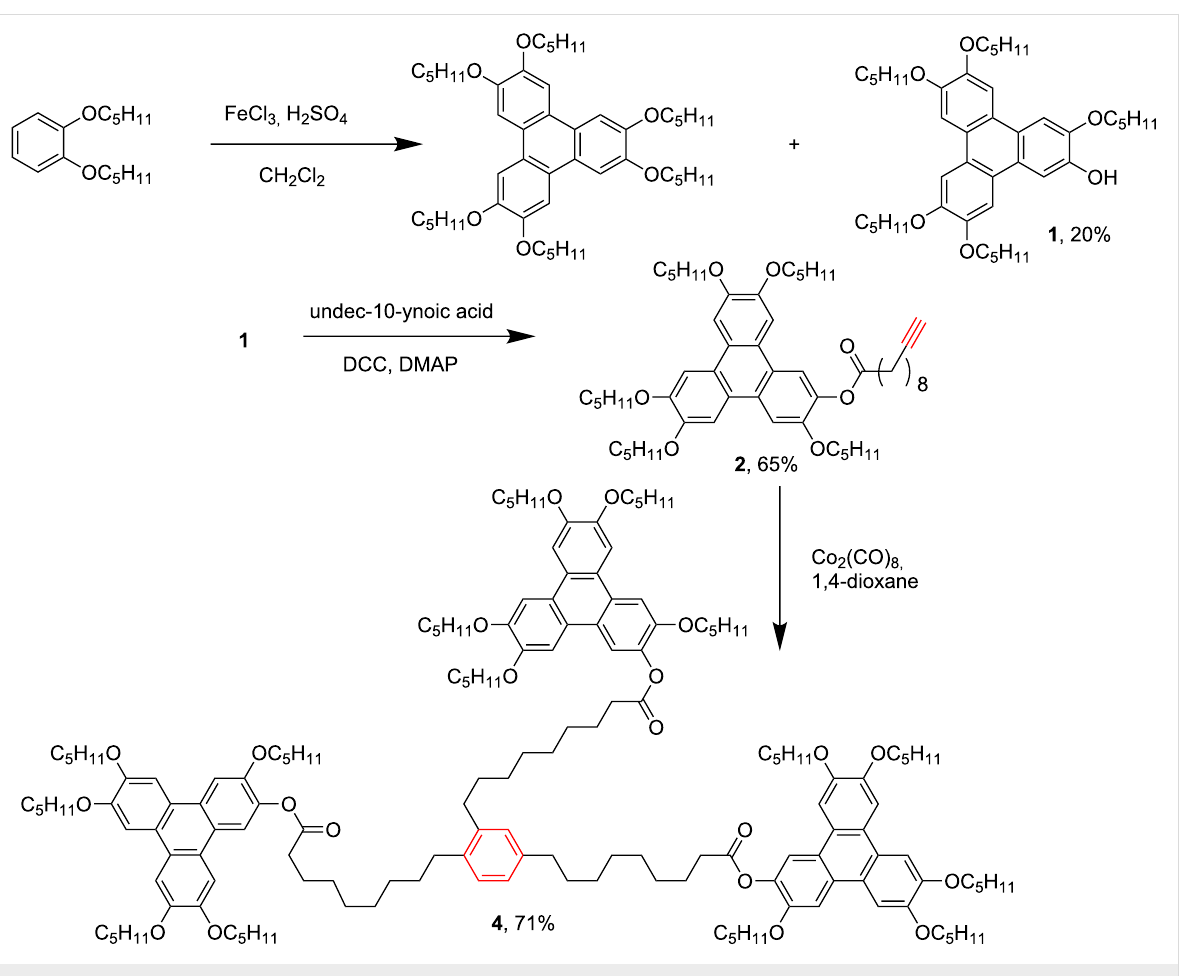
Scheme 1: Synthesis of star-shaped triphenylene discotic liquid crystalline trimer 4